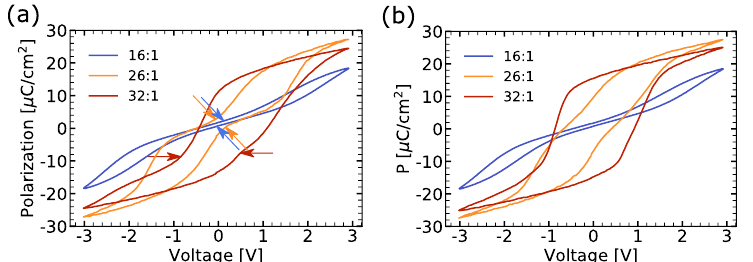
Figure 3. Polarization response of hybrid HSO samples with different cycling ratios. Initial response is shown in ( a ). Arrows indicate the observed pinching. After cycling (10,000 electric field cycles), the samples with less Si-doping show wake-up and imprint reductions ( b